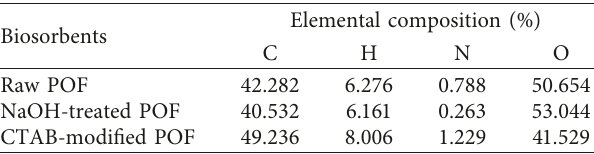
Figure 4: XRD curves of (a) raw POF, (b) NaOH-treated POF, and (c) CTAB-modified POF. Table 1: Elemental analysis of raw, NaOH-treated, and CTAB- modified POF.